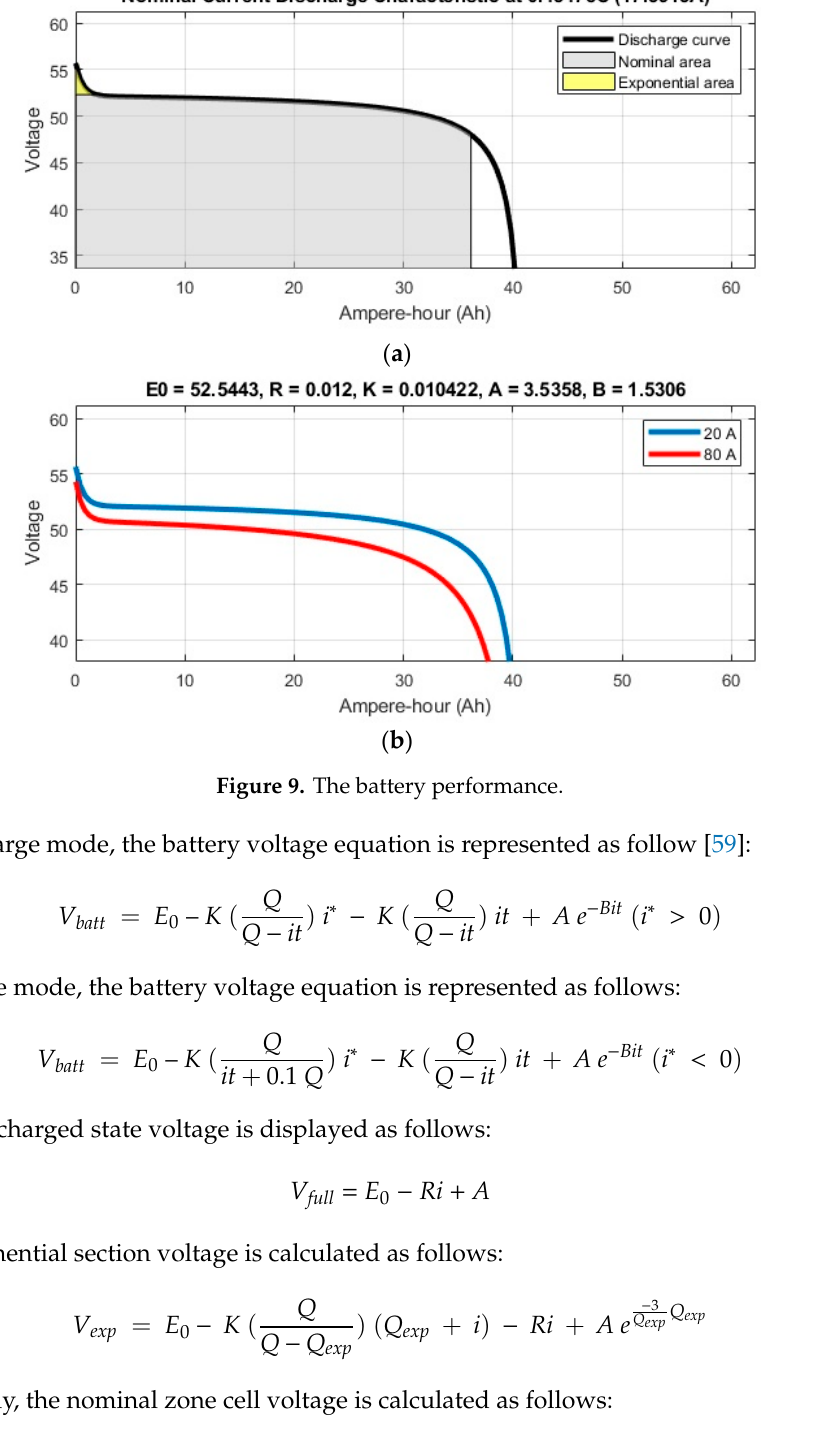
Table 5. Supercapacitor (SC) main parameters.